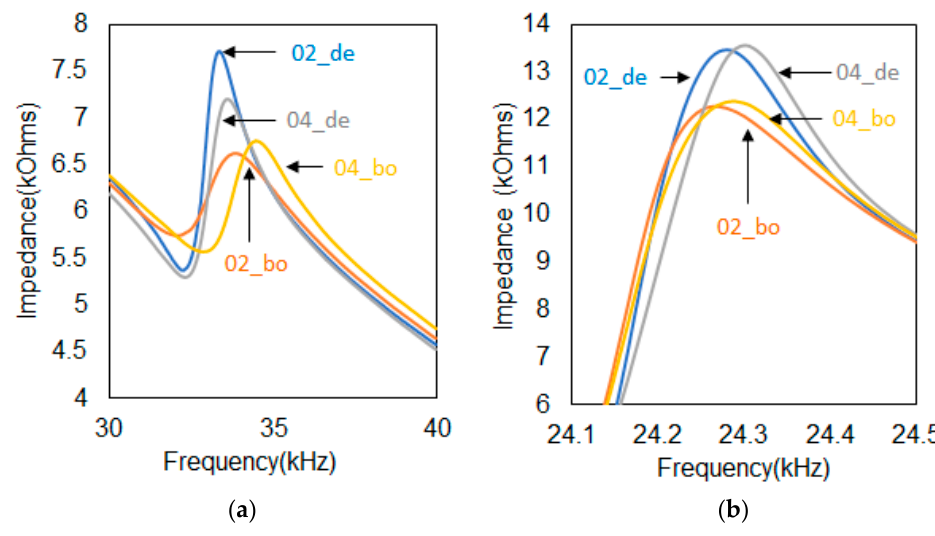
Figure 5. Averaged impedance signature signatures from ( a ) Figure 3; ( b ) Figure